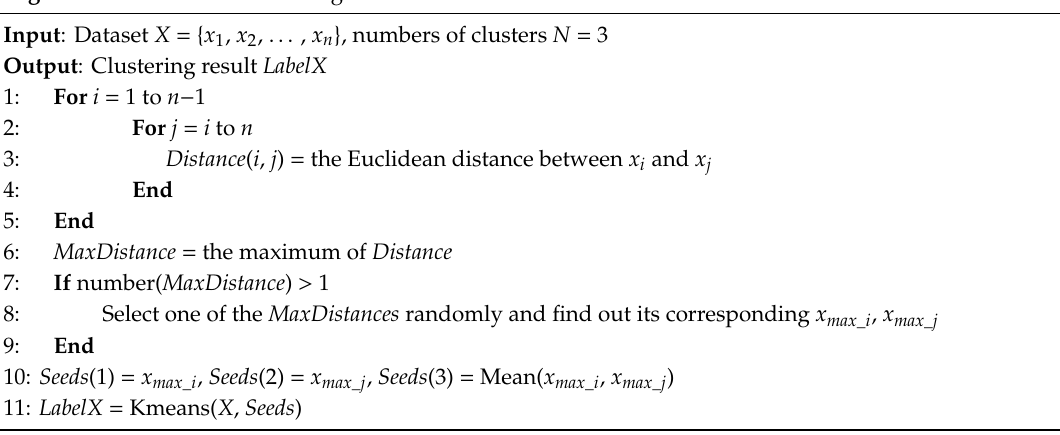
Algorithm Modified K-means Algorithm